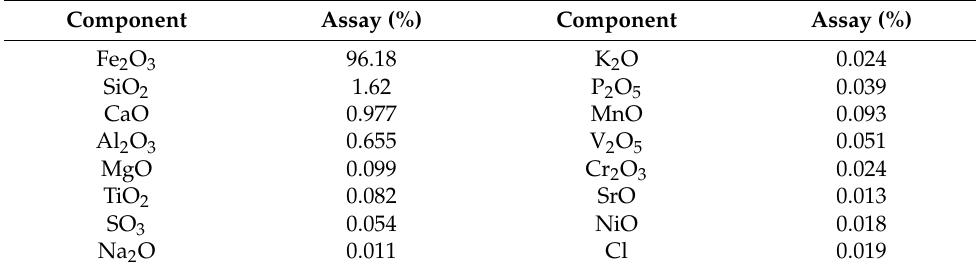
Table 1. Complete chemical analysis of iron ore fine sample (wt